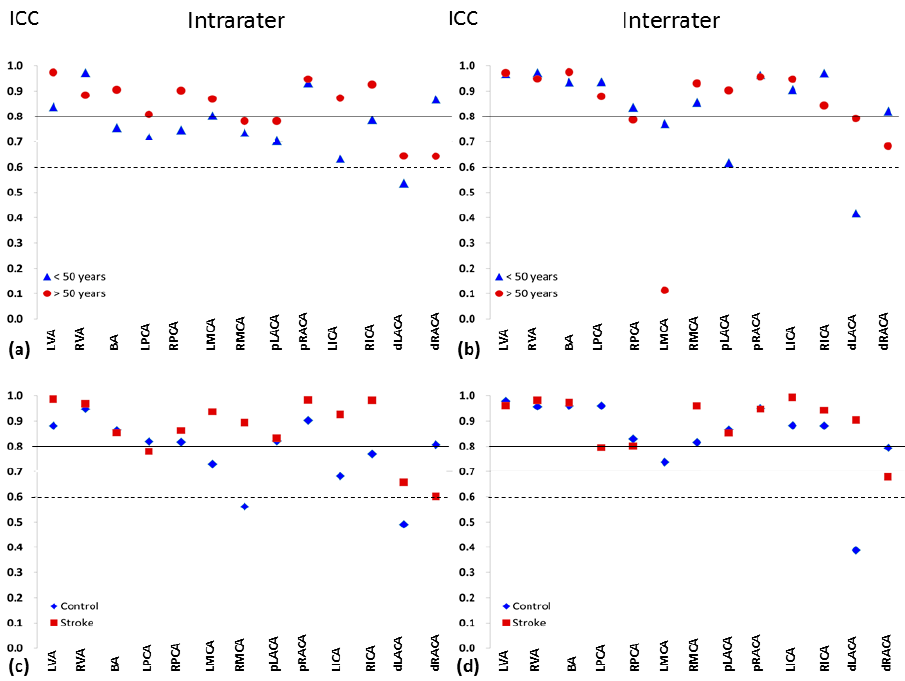
Figure 3. Intra- and inter-rater repeatability and reproducibility of blood flow volume measures at each cerebral artery, compared between participants aged less than 50 years (triangle, n = 15) and those aged at least 50 years (circle, n = 15) and between patients with stroke (square, n = 8) and without stroke (controls; diamond, n = 22). The dotted horizontal line indicates the minimum intraclass correlation coefficient (ICC) for good reliability; the solid line indicates the minimum ICC for excellent consistency. BA, basilar artery; dLACA, distal segment of the left anterior cerebral artery; dRACA, distal segment of the right anterior cerebral artery; ICC, average-measures intraclass correlation coefficient; LICA, left internal carotid artery; RICA, right internal carotid artery; LMCA, left middle cerebral artery; RMCA, right middle cerebral artery; LPCA, left posterior cerebral artery; RPCA, right posterior cerebral artery; LVA, left vertebral artery; RVA, right vertebral artery; pLACA, proximal segment of the left anterior cerebral artery; pRACA, proximal segment of the right anterior cerebral artery.